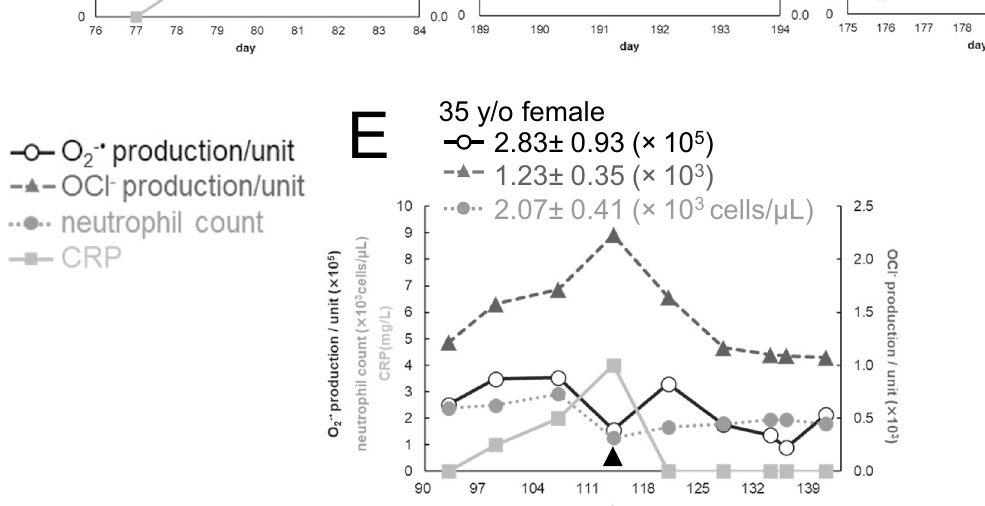
Figure 5. Day-to-day variations of the cellular ROS production capacities. Scatter plots showing the day-to- day fluctuations of the O 2−· production/unit ( ○ solid line), the OCl − production/unit ( ▲ dashed line), the neutrophil counts ( dotted line), and CRP ( ■ solid line). The left vertical axes indicate the O 2−· production/ unit, the neutrophil counts and CRP; the right vertical axes, the OCl − production/unit. The horizontal axes ● indicate dates (weekly intervals) during the measurements. The mean values of the O 2−· production/unit, the OCl − production/unit and the neutrophil counts together with the variation ranges of them were indicated at the upper-left in each figure. ( A ) 52 y/o male (complete data) as an example of six subjects. ( B ) 35 y/o male, partially expanded view (Day 76–84). ( C ) 54 y/o female, partially expanded view (Day 189–194). ( D ) 54 y/o female, partially expanded view (Day 175–183). ( E ) 35 y/o female, partially expanded view (Day